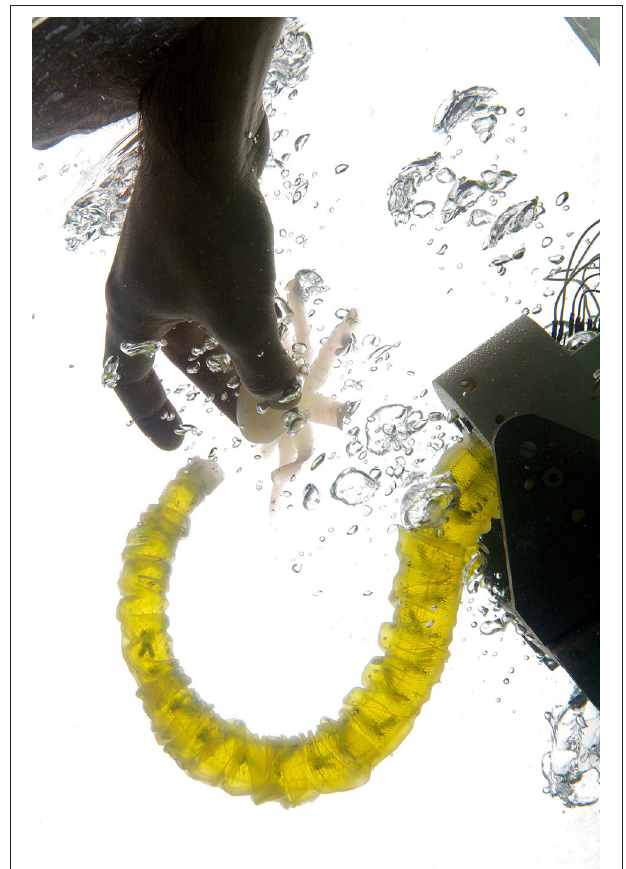
FIGURE 3 | The Lighthouse: prototype of an artificial bio-inspired arm developed during the EU OCTOPUS Integrating project, 231608 (photograph by Massimo